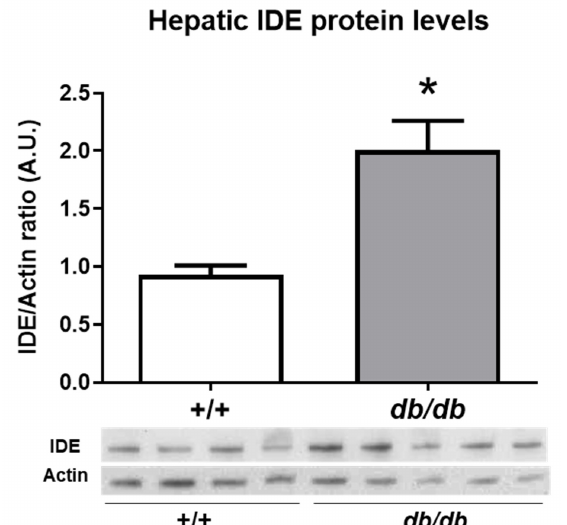
Figure A4. IDE activity in liver, skeletal muscle, and kidneys from WT and IDE-KO mice. Tissue extracts from WT and IDE-KO mice were prepared and assessed for IDE activity. Significance is